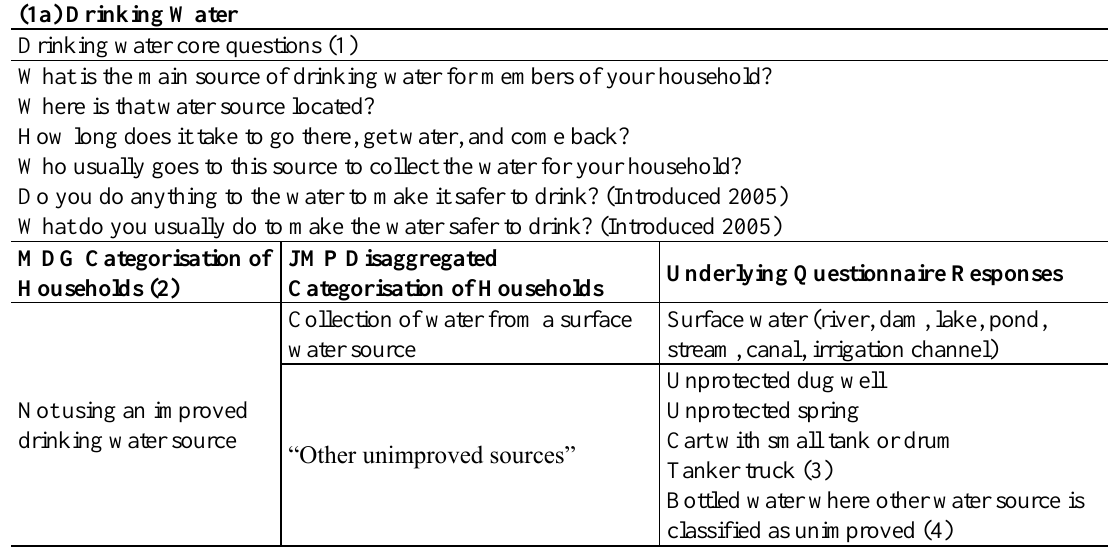
Table 1. JMP categorisation of drinking water and sanitation coverage according to use of different facility classes. Also shown are core questions on water, sanitation, and